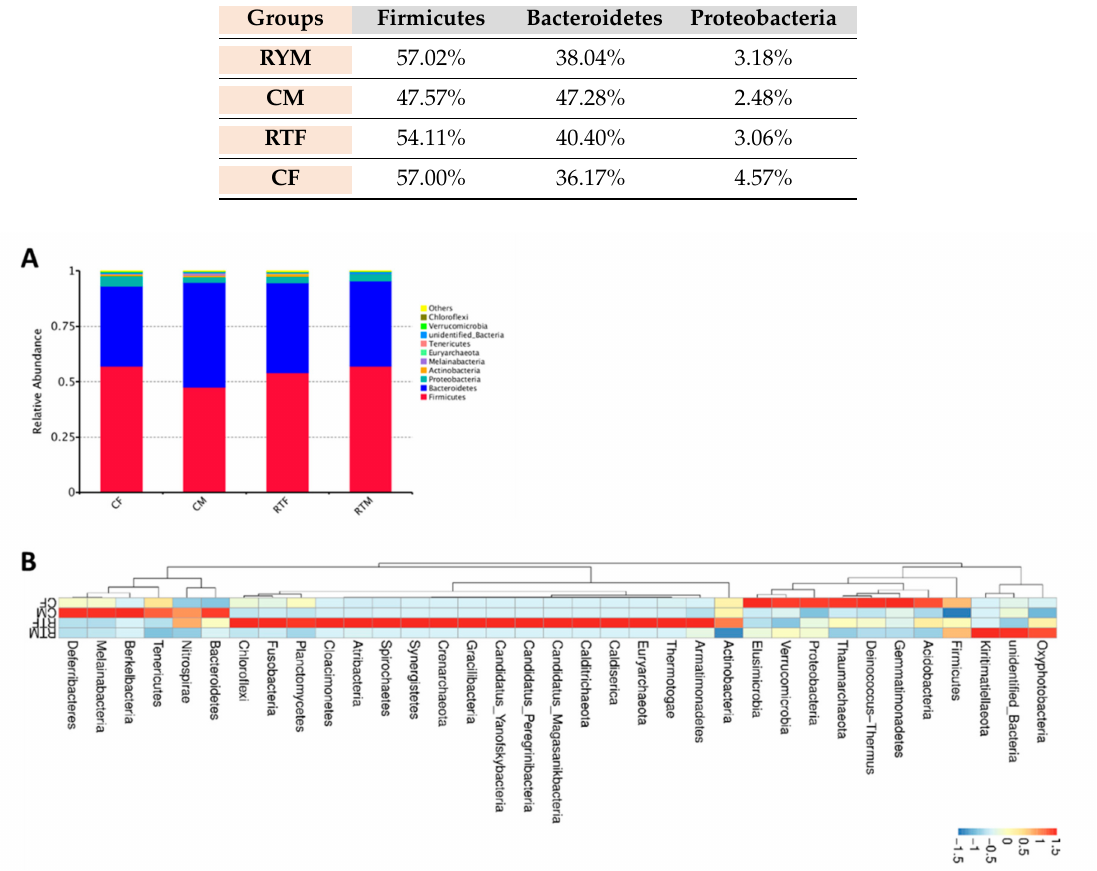
Figure 2. The proportion of dominant phyla in each group. ( A ) Relative abundance histogram of the gut microbiota of the o ff spring, ( B ) cluster heat map of the gut microbiota in the phylum level. Cold female (CF), cold male (CM), room temperature female (RTF), and room temperature male